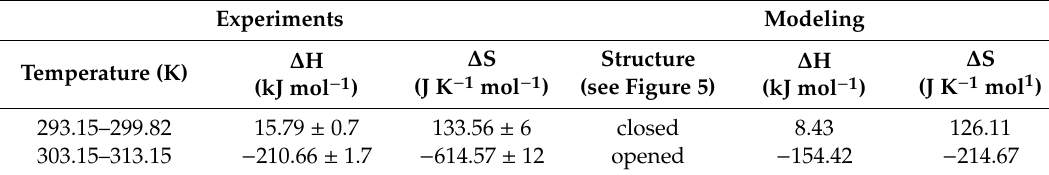
Table 2. Thermodynamic parameters of the complex formation between TAC and MTX